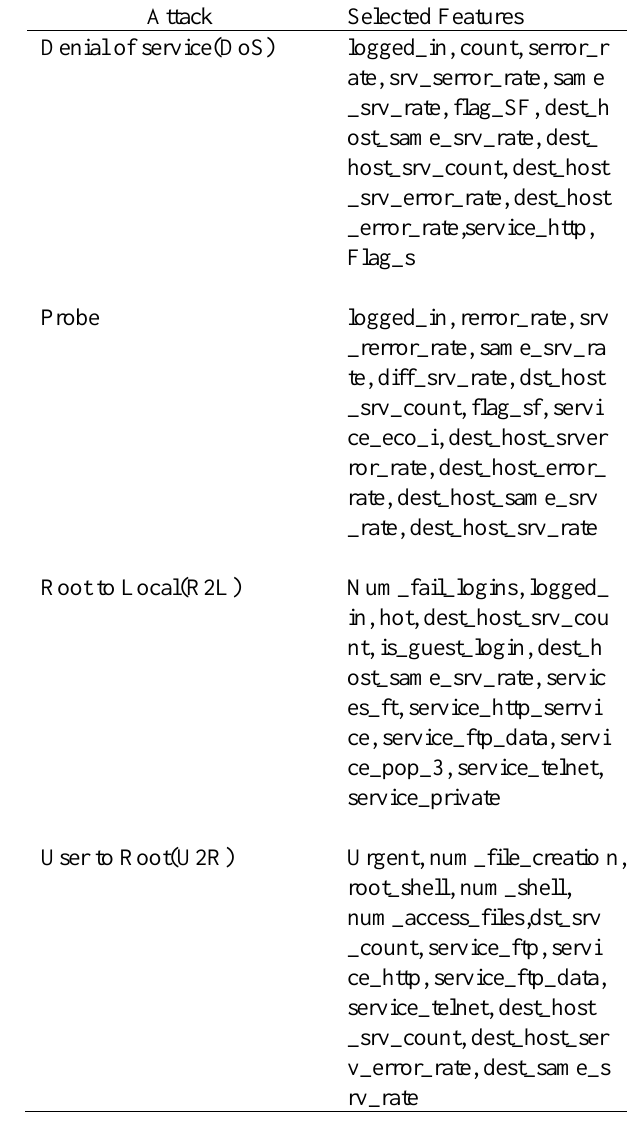
Selected features for each attack Attack Selected Features